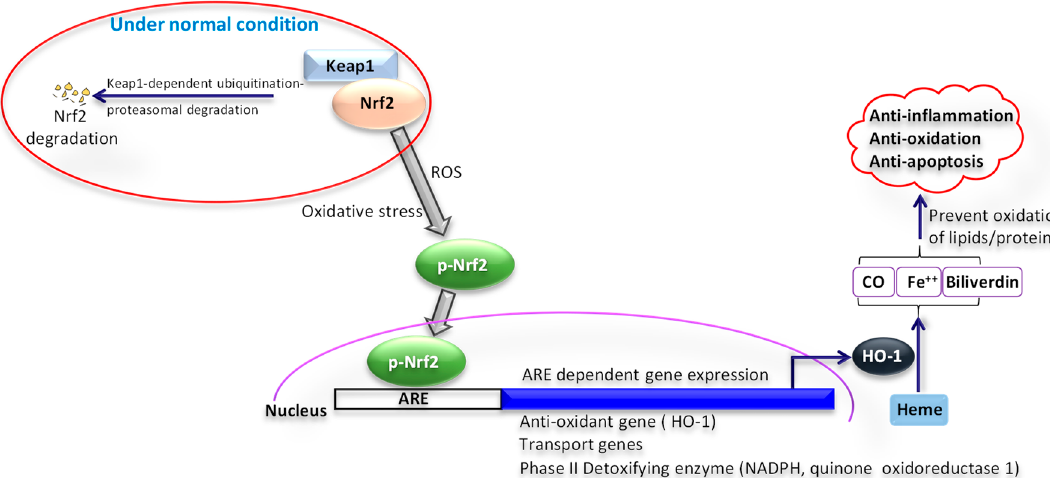
Figure 3. Role of nuclear factor erythroid 2-related factor 2/hemeoxygenase-1 (Nrf2/HO-1) signaling pathway in oxidative stress. Under normal condition, Nrf2 is bound to Kelch-like ECH-associated protein-1 (Keap1), gets ubiquitinated through Keap1, and undergoes proteasomal degradation. Under oxidative stress conditions, when exposed to reactive oxygen species (ROS), Keap1 inactivates and Nrf2 phosphorylation occurs. Phosphorylated Nrf2 (p-Nrf2) moves to the nucleus, where it binds to the antioxidant response element (ARE). As a result, numerous genes are activated, such as transport molecules, antioxidants, and detoxifying enzymes. This leads to an upregulation of hemeoxygenase -1 (HO-1). Upregulated HO-1 leads to a reduction of oxidative stress. HO-1 is a crucial endogenous antioxidant and creates an essential defense system. HO-1, when activated by Nrf2, can metabolize Heme into its metabolites Fe 2+ , CO, and biliverdin. These metabolites along with HO-1 by scavenging superoxide, hydroxyl-free radicals, and singlet oxygen can prevent the oxidation of proteins and lipids anions and play an important part in anti-inflammation, antioxidation, and anti-apoptosis.